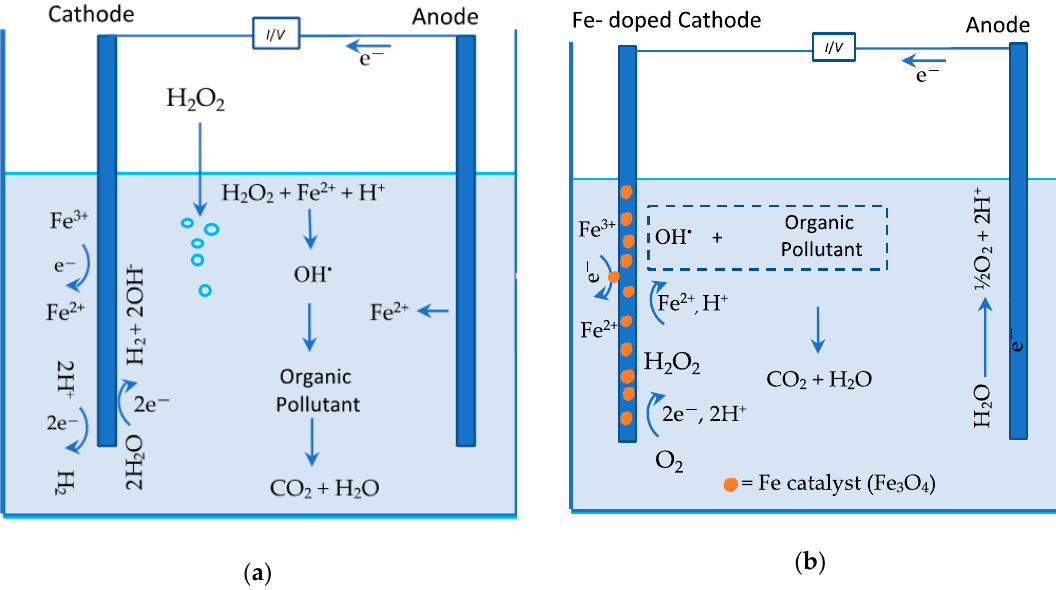
Figure 1. Schematic of ( a ) homogeneous and ( b ) heterogeneous electro-Fenton (E-Fenton).